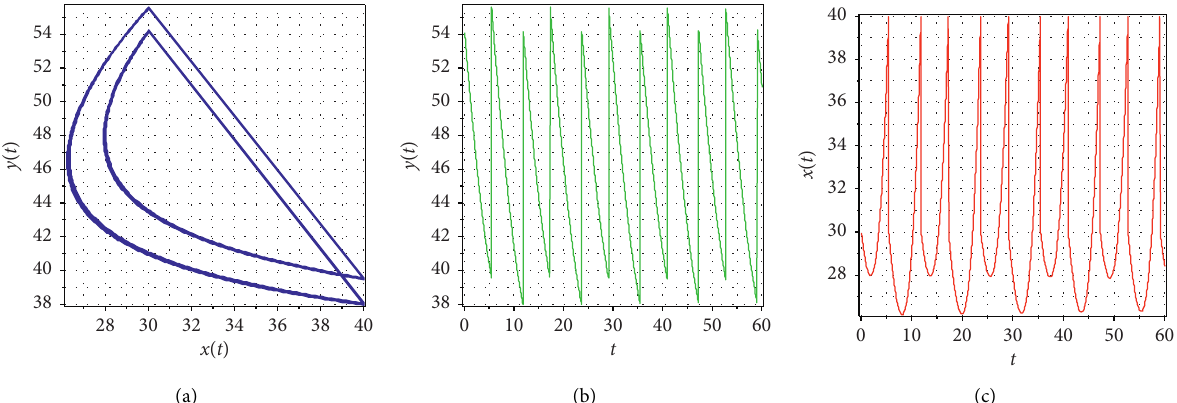
Figure 8: Numerical simulation of the order-2 periodic solution. (a) Phase portrait of x ( t ) and y ( t ). (b) Time series of y ( t ). (c) Time series of x ( t